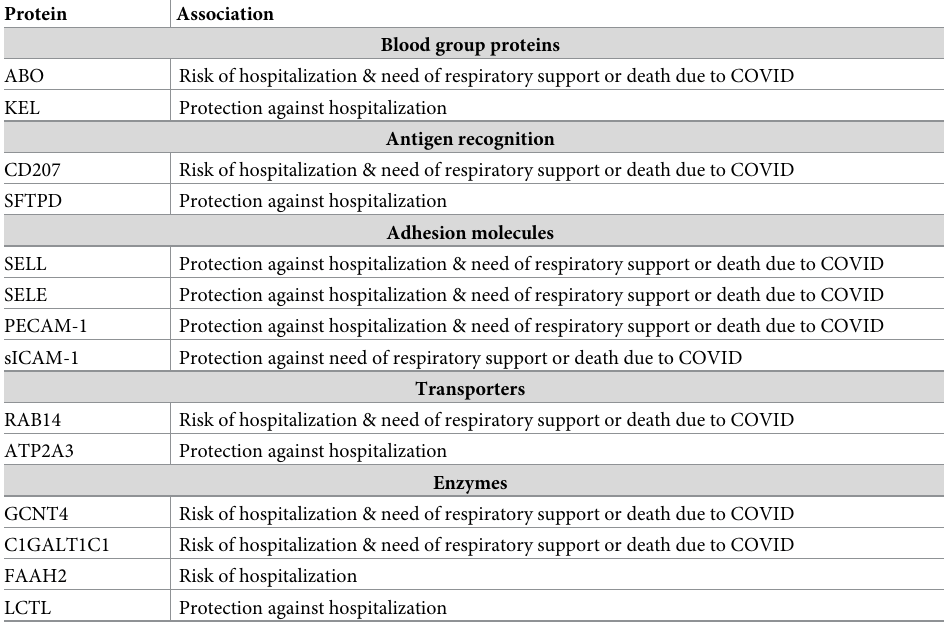
Table 2. Groupings of statistically significantly associated proteins by their biological